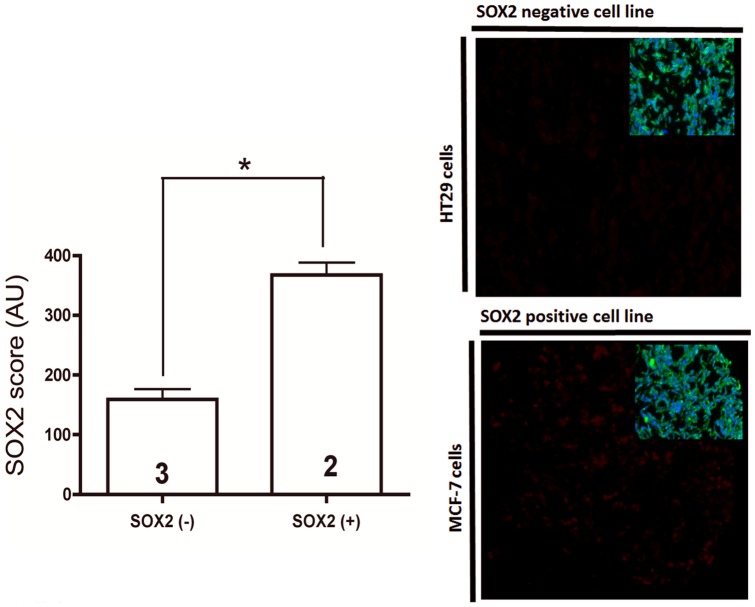
Validation of the assay using tumor cell lines with know SOX2 expression (MCF7 and BT474).SOX2 positive cell lines (MCF7 and BT474) show significantly higher SOX2 AQUA scores compared to cells with known low SOX2 expression (MB435, HT29 and A431 cell lines) (P value = <0.01). Representative fluorescence microphotographs of SOX2 immunoreactivity (red fluorescence channel) in MCF7 and HT29 cells. Insets shows cytokeratin immunostain(AE1/AE3, green channel) and nuclear DAPI fluorescence (blue channel). in the corresponding TMA spots.